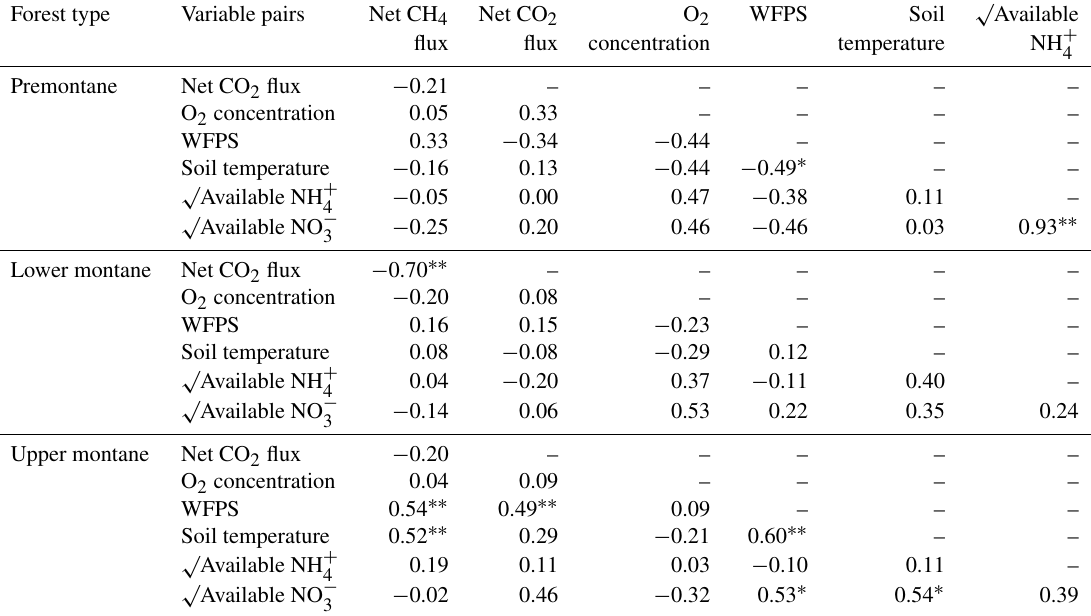
Table 4. Pearson’s correlation coefficient matrix for monthly forest type means of measured variables within forest types. Forest